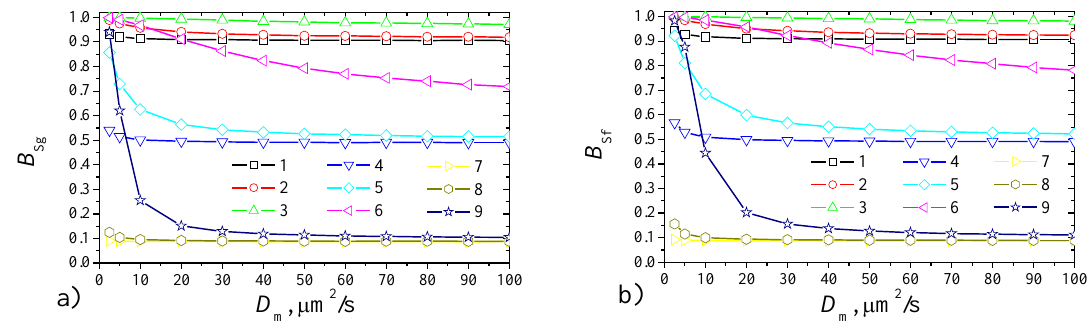
of the outer membrane in the m